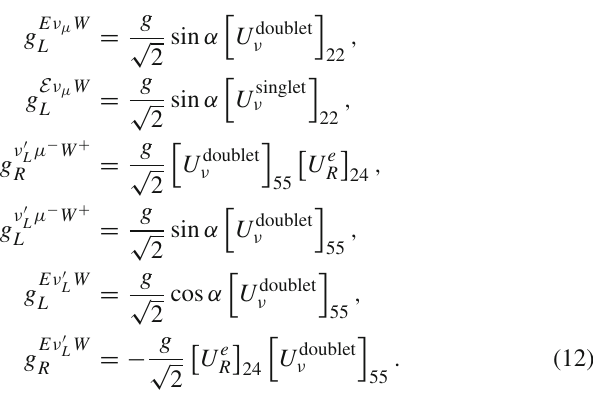
denotes the VLL L